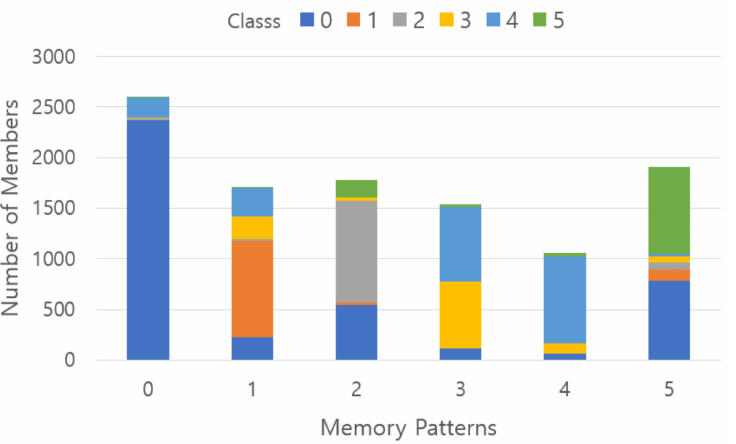
Figure 24. Results of stored memory pattern in an experiment using 20% SDR overlap with the pre-memory process for Fashion-MNIST dataset; x -axis represents class numbers, y -axis describes the number of members belonging to each memory pattern, and a vertical color code indicates a memory pattern ratio belonging to each